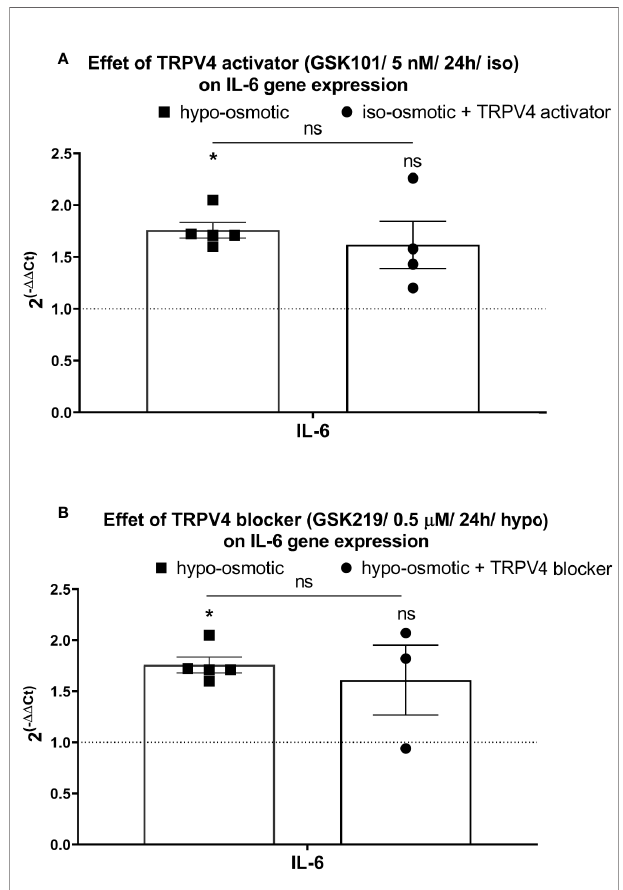
FIGURE 8 | The mRNA expression of IL-6 in NP cells after 24 h of treatment with (A) TRPV4 activator (5 nM GSK1016790A) or (B) TRPV4 blocker (500 nM GSK2193874). Graphs show 2 − DD Ct values normalized to the iso-osmotic control (mean ± SEM, bNP P2, n = 3 – 4). Asterisks indicate statistical signi fi cance (*p < 0.05, ns , no statistical difference de fi ned at p > 0.05) between hypo-osmotic group, iso-osmotic group, or iso-osmotic activator- supplemented